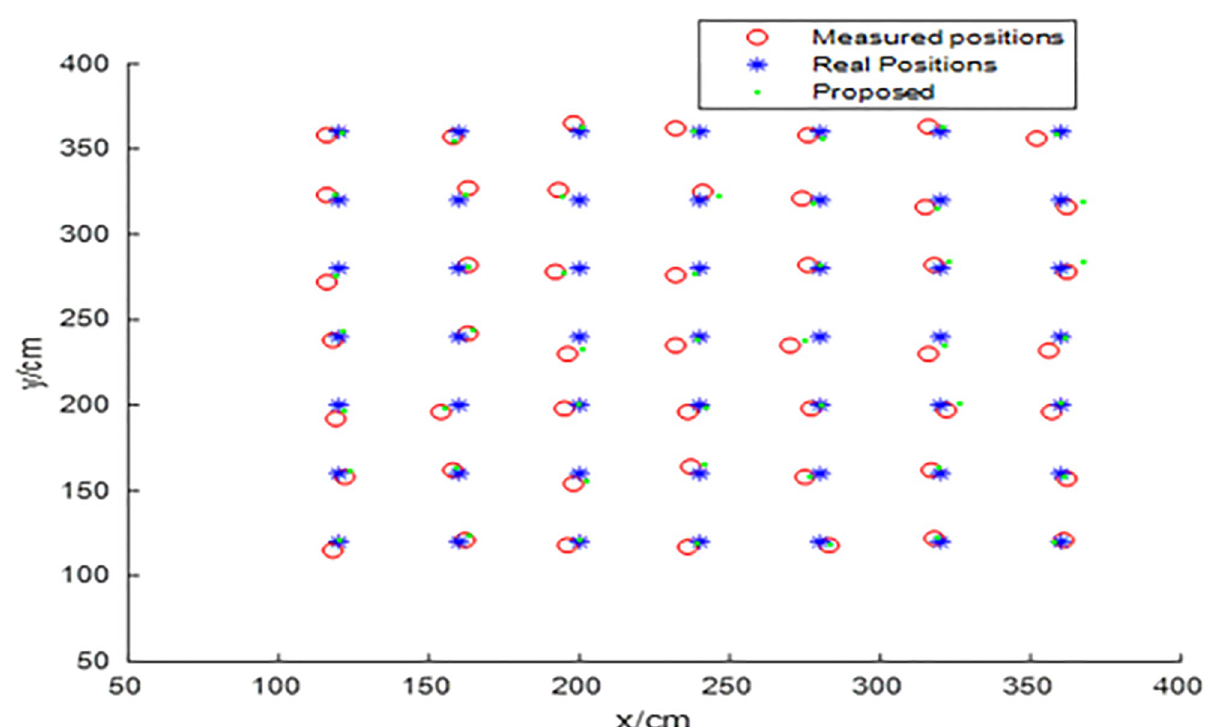
Fig 13. Predicted, real and measured